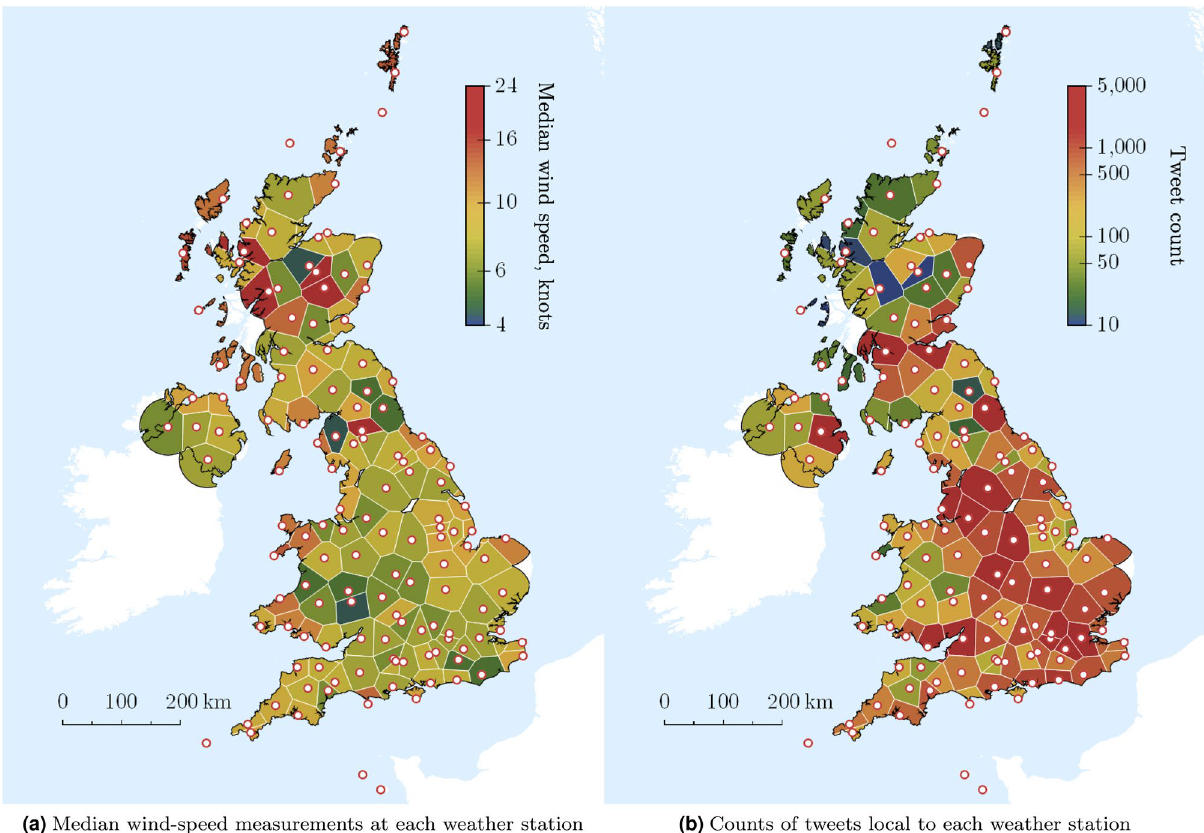
Figure 3. Wind speeds and tweet density across the UK. Plots show the distribution of observed wind speeds (median value of 20-minute averages across the study period) and associated tweet counts for 135 weather stations maintained by the UK Met Office. There is substantial variability in both tweet volumes (which are strongly correlated with population density) and wind speeds (with regions close to the coastline and further north generally experiencing stronger daily winds). Tweets further than 50 miles from a weather station are